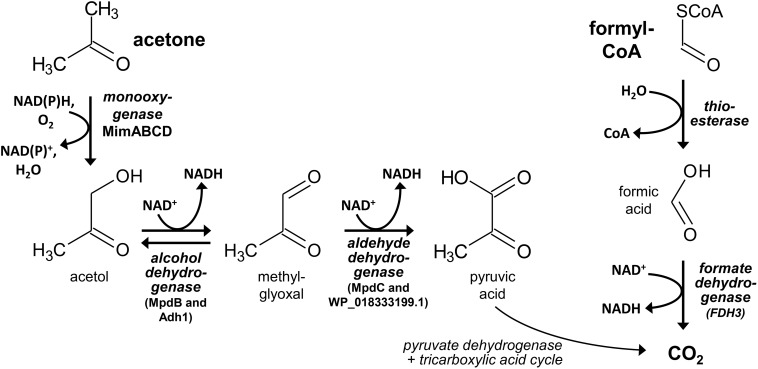
Proposed reaction steps for the degradation of the 2-hydroxyisobutyryl-CoA cleavage products acetone and formyl-CoA in strain A. chiangmaiensis DSM 45062. Likely, hydroxylation of acetone and the subsequent acetol oxidation to methylglyoxal are catalyzed by the Mim cluster diiron monooxygenase and alcohol dehydrogenase Adh1 (WP_018330678.1), respectively. Only in 2-HIBA-grown cells, alcohol oxidation may also involve MpdB and methylglyoxal could be oxidized by MpdC. By contrast, the aldehyde oxidation is likely taken over by dehydrogenase WP_018333199.1 when cells are incubated on acetone. Formyl-CoA may be hydrolyzed to formic acid, which can be oxidized by 2-HIBA-induced cytoplasmic NAD+-dependent formate dehydrogenase FDH3.